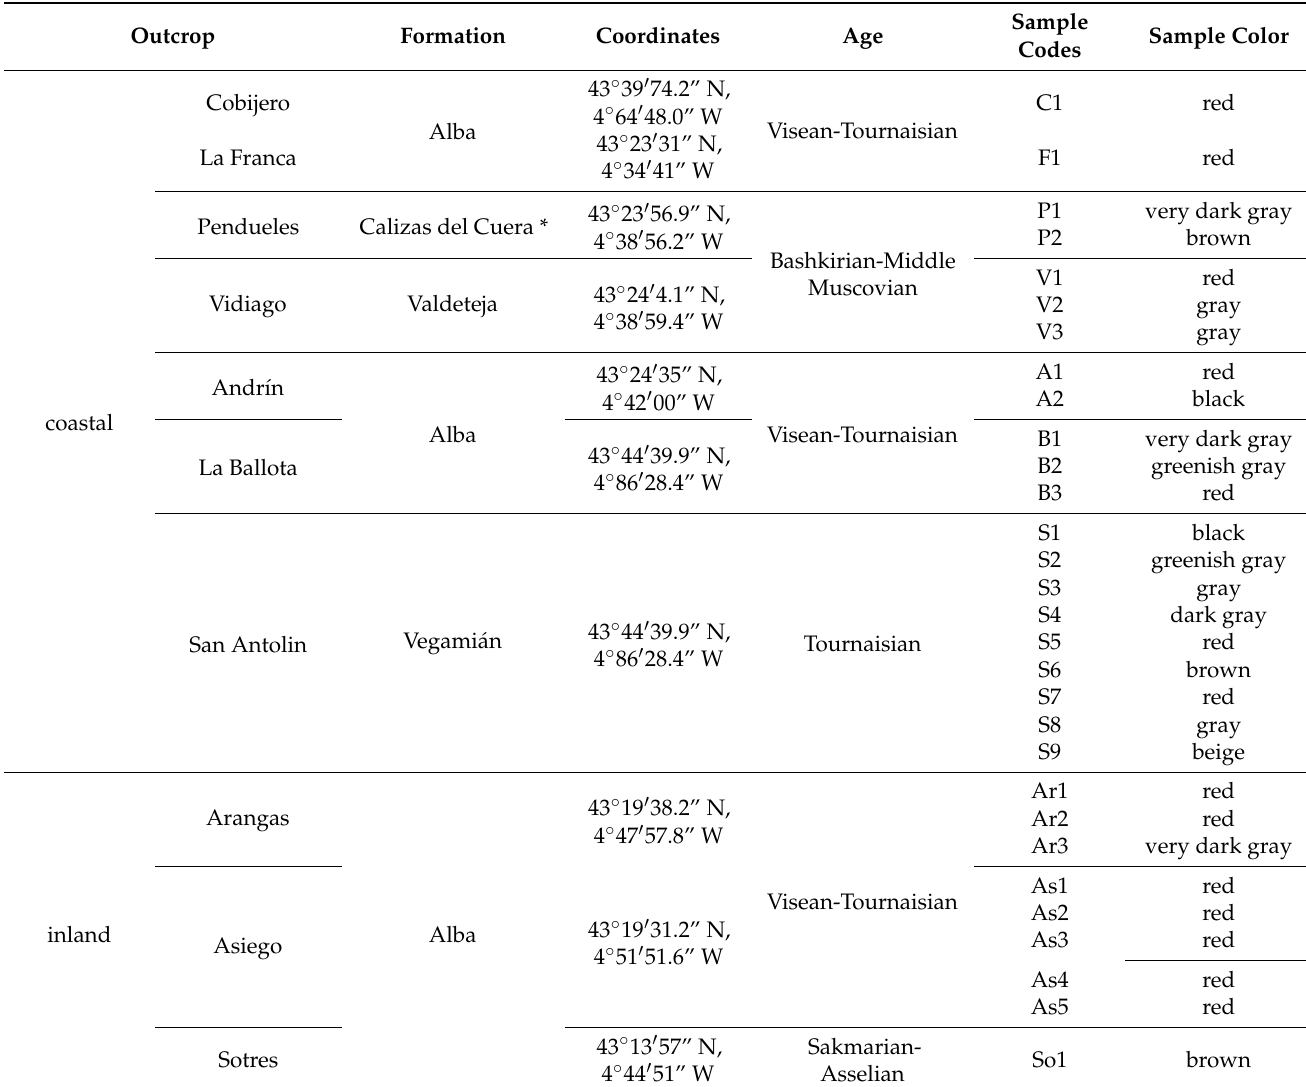
Table 1. Formations, age, color and codes of the chert samples from the outcrops (Note: * Assimilable to the Valdeteja and Picos de Europa